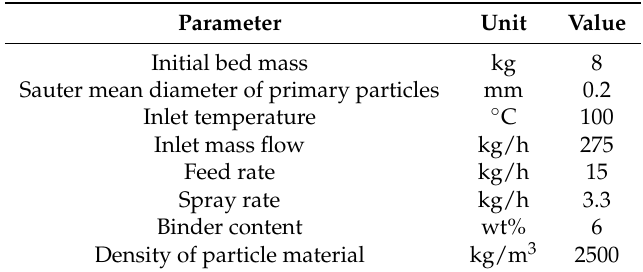
Table 1. Overview of experimental